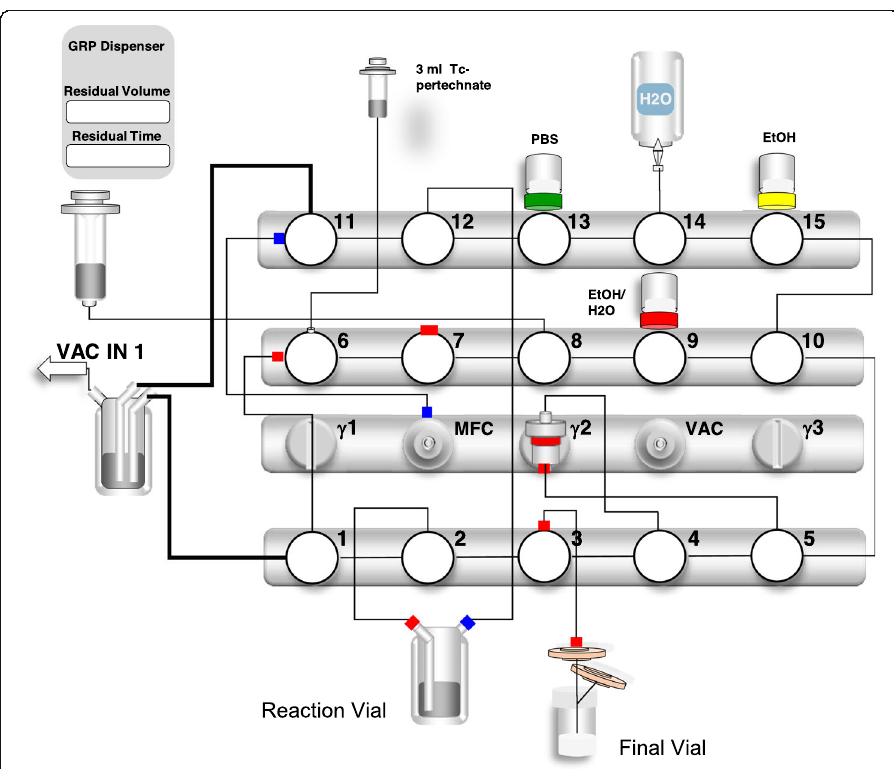
Fig. 1 Set-up of the automated Scintomics system for radiolabeling of 99m Tc-PSMA